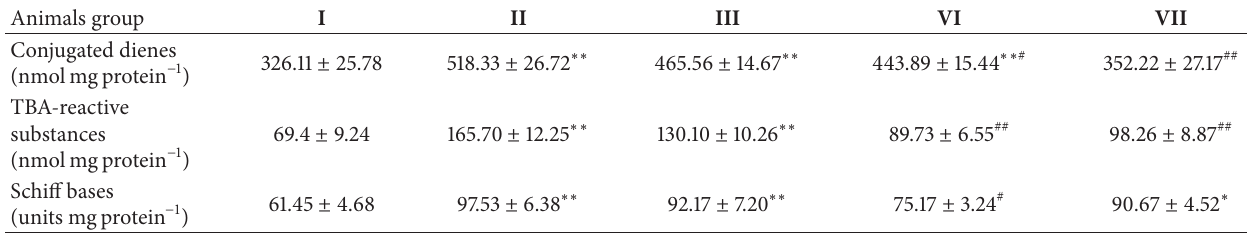
Table 1: Influence of compounds 3 (group VI ) and 4 (group VII ) (1mg/kg, IP, 30 min before WIRS) on the content of lipid peroxidation products in homogenates of rats gastric mucosa ( 𝑛 = 6 , M ± m).